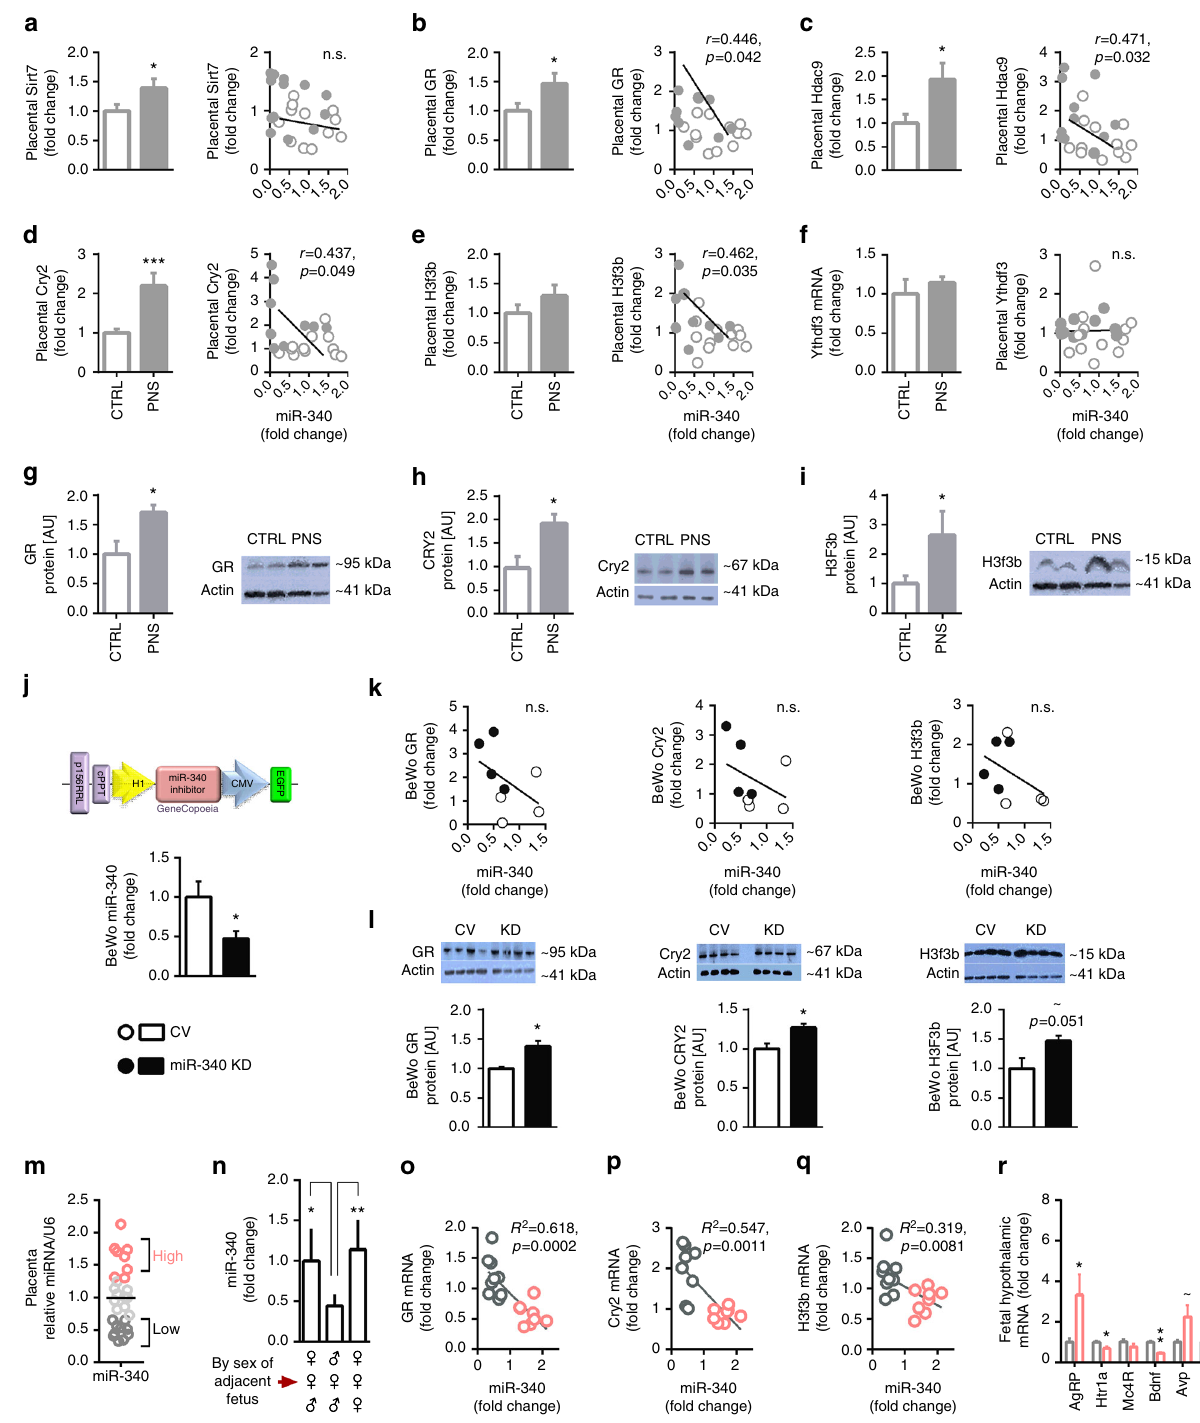
Fig. 3 MiR-340 exerts its effects through targeting of GR, Cry2, and H3f3b. a − f Validation of potential miR-340 target in prenatal stress (PNS) vs. control female placentas showed that Sirt7 and Ythdf3 were not signi fi cantly correlated with miR-340 ( a , f ). b − e In contrast, GR , Hdac9 , Cry2 , and H3f3b expression was signi fi cantly higher in PNS and inversely correlated with miR-340. g − i Placental GR, CRY2, and H3F3b protein levels were increased by PNS ( N = 4). j Lentiviral KD of miR-340 in BeWo choriocarcinoma cells reduced the expression of miR-340 ( F (1,7) = 5.654, p = 0.050, N = 4). k MiR-340 KD did not signi fi cantly affect mRNA levels of the target genes. l At the protein level, miR-340 KD increased GR ( t (6) = 3.687, p = 0.010) and CRY2 ( t (6) = 3.156, p = 0.0197), and tended to increase H3F3b. m Within the control group, miR-340 expression shows great endogenous variability ( N = 28, from six dams). n Female fetuses surrounded by two males in the uterus show lower levels of placental miR-340 compared to females surrounded by females or mixed sexes (one-way ANOVA F (2,23) = 9.31, p = 0.0013). Data are presented in mean and s.e.m. and Tukey ’ s multiple comparison tests. o − q The “ high ” and “ low ” subgroups included samples above 1.3 and below 0.70 relative to the groups ’ average respectively. The expression of GR , Cry2 , and H3f3b inversely correlated with the endogenous levels of miR-340. Data are presented as mean and s.e.m. r Fetal hypothalamic gene expression of AN candidate genes differed between the “ high ” and “ low ” subgroups ( F (6,5) = 13.1, p = 0.006). Data are presented in mean and s.e.m. ( N =